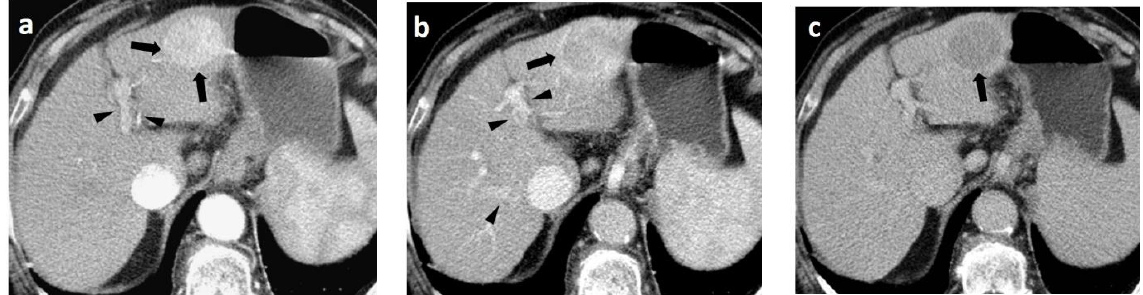
Figure 5. Typical hallmark imaging features of HCC in a 60-year-old patient with HBV cirrhosis. ( a ) Late arterial phase, ( b ) Portal-venous phase, and ( c ) Delayed phase. MDCT images show a 30-mm mass in the left liver lobe with global APHE (arrows) ( a ) “wash-out” on the PVP (arrow) ( b ), and capsule appearance on both the PVP and delayed phase (arrow) ( b , c ). Note the enhancement of both the left hepatic artery and portal vein with no enhancement of the hepatic veins on the late arterial phase (arrowheads) ( a ) and enhancement of the left hepatic artery, portal vein, and hepatic veins on PVP (arrowheads) ( b ). Table 3. CT/MRI LI-RADS ® v2018 Diagnostic Table by the American College of Radiology (ACR) [51]. LR-3 observations are marked in yellow, LR-4 are marked in orange and LR-5 are marked in red.